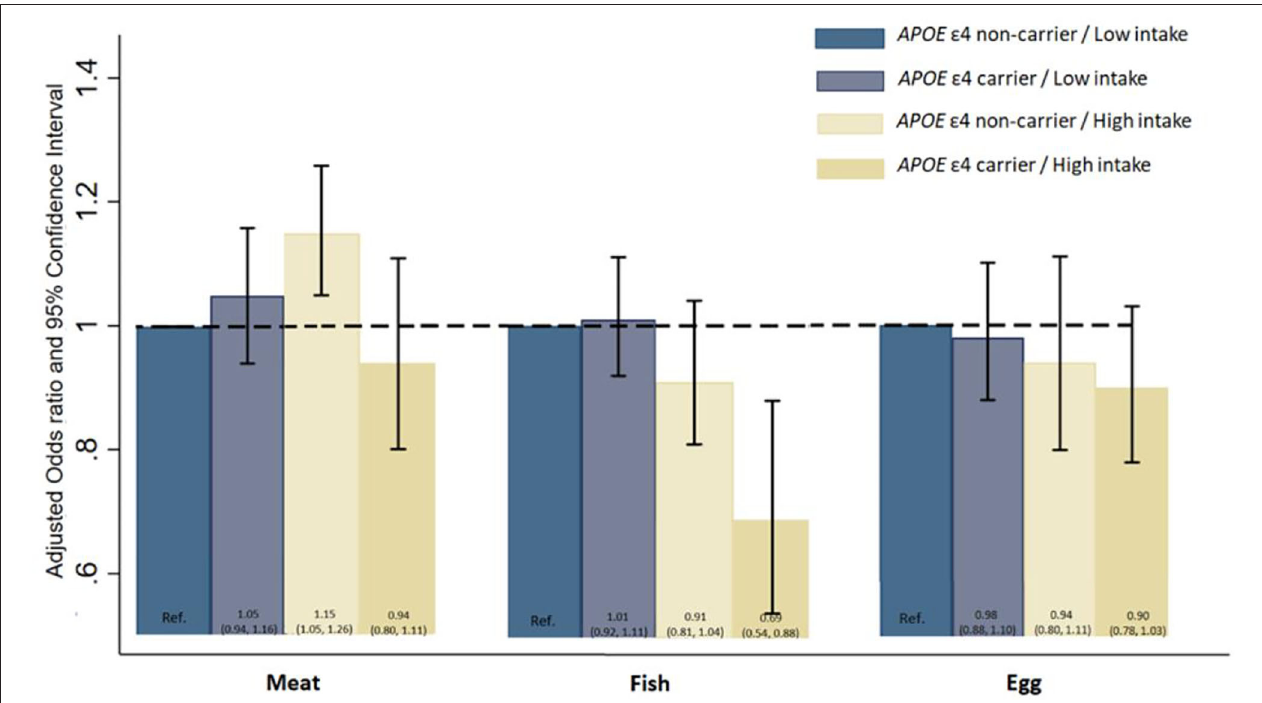
FIGURE 2 | Hazard ratios and 95% Confidence Interval for all-cause mortality by a joint classification of the APOE E4 genotype and meat, fish, and egg intake. Model was adjusted for age, sex, education, marital status, ethnicity, living arrangement, residence, occupation, other nine kind of dietary components tobacco smoking status, alcohol drinking status, current physical activity, abnormal body weight, activity of daily living, leisure activity score, mini-mental state examination score, and eight kinds of self-reported diseases (COPD, tuberculosis, cancer, cataract, glaucoma, diabetes, stroke, and cardiovascular